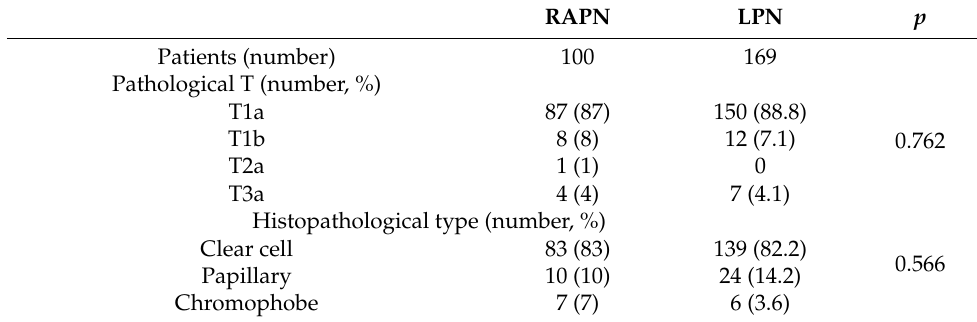
Table 3. Pathological outcomes.